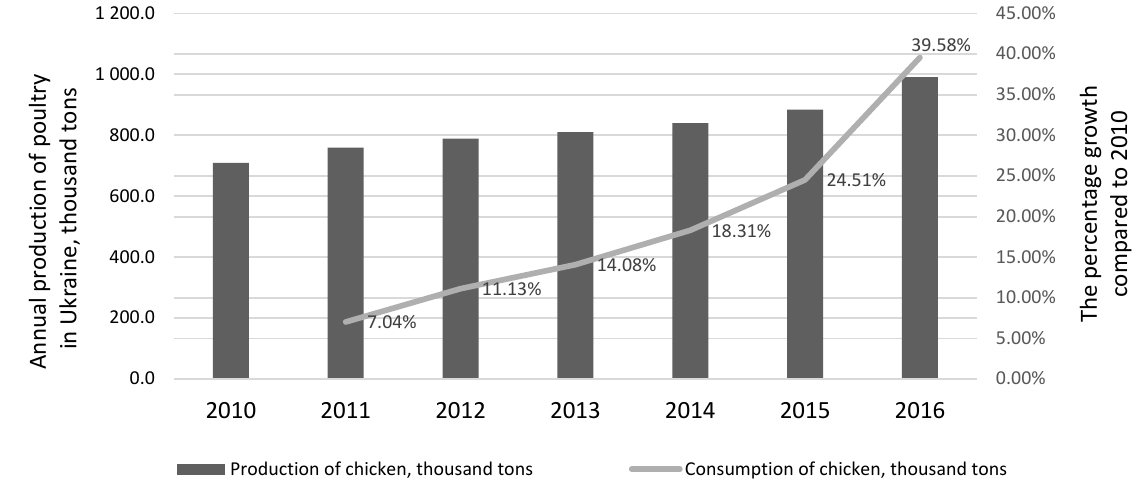
Figure 1. Annual production of poultry for Ukraine in